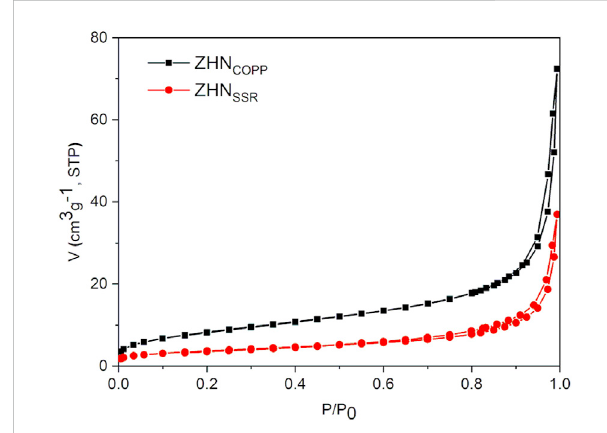
FIGURE 3 N 2 adsorption – desorption isotherms of the samples.